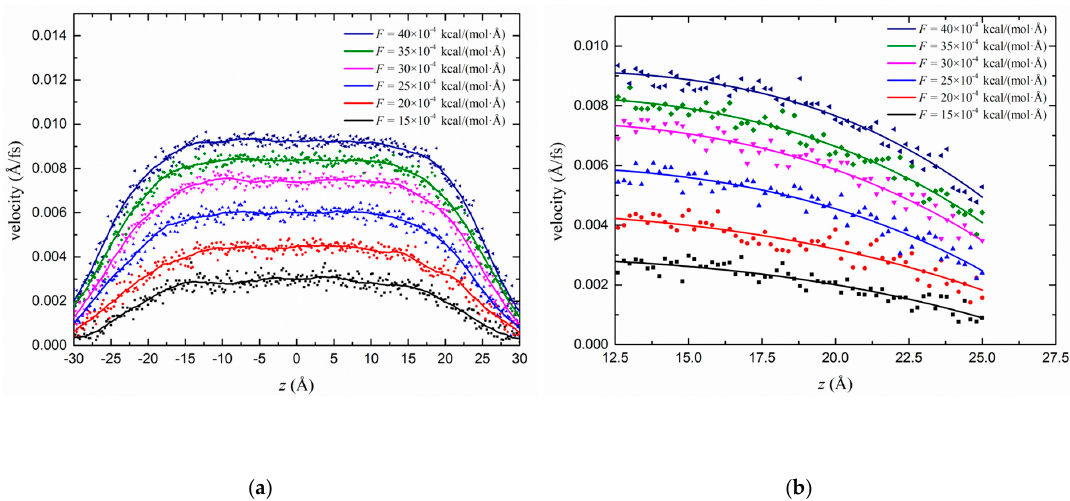
Figure 4. Velocity profiles: ( a ) The velocity profile of the shale oil at different driving forces. ( b ) The velocity profile in the boundary layer. T = 300 K.